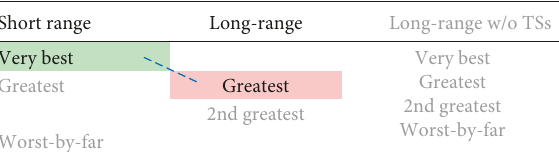
Table 17: Tabular representation of Rule 6c.